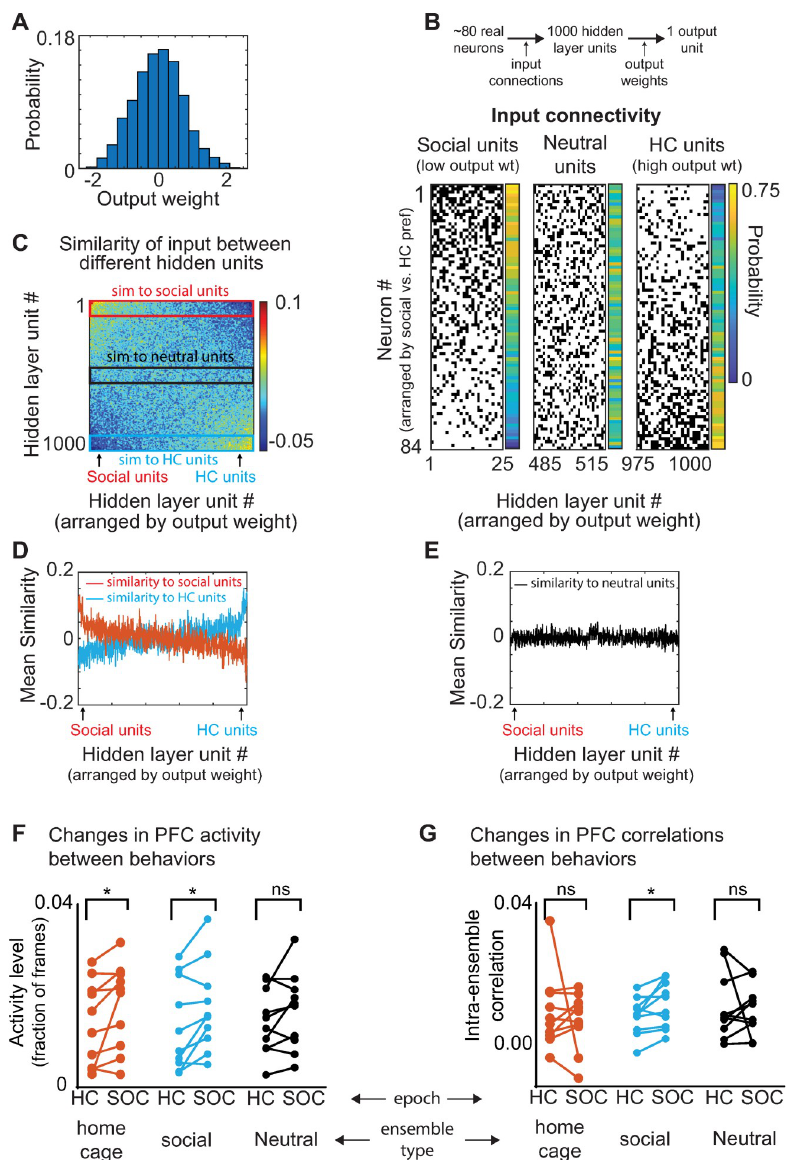
Fig 3. Classifier weights reveals an ensemble that increases correlations during social behavior and detects social behavior. (A) Example histogram depicting the distribution of output weights assigned to connections between hidden layer units and the output unit over the course of training. (B) Matrix of input connections for hidden units which detect the social (left) or HC condition (right). The hidden layer units (x-axis) have been arranged in order of increasing output weights to identify “social units” (25 most negative output weights) and “HC units” (25 largest positive output weights). We also plotted “neutral units” (30 units closest to 0). To the right of each matrix is the probability that a given neuron will be connected to a given set of units. Prefrontal neurons (y-axis) have been arranged in order of their preference for social interaction vs. HC, i.e., the difference in their probability of being connected to home cage versus social units. (C) Correlation matrix showing the input similarity, i.e., the pairwise correlation between binary vectors representing the input connections to each pair of hidden layer units. Hidden layer units are arranged in order of increasing output weight. Red and blue rectangles indicate the input similarity compared to social or HC units, respectively. A Gaussian filter with a standard deviation of 3 was applied to the 1,000 × 1,000 matrix to improve visualization. (D) For each hidden layer unit, we plotted its average input similarity to either the 25 social units (red) or the 25 HC units (blue). Hidden layer units (x-axis) are again arranged by output weight. Social units had similar patterns of input compared to each other but not to HC units and vice versa. (E) The average input similarity of each hidden layer unit to 25 hidden layer units with near-zero output weights (“neutral units”; black rectangle in C). (F) We defined social and HC ensembles as the 20% of prefrontal neurons most likely to provide